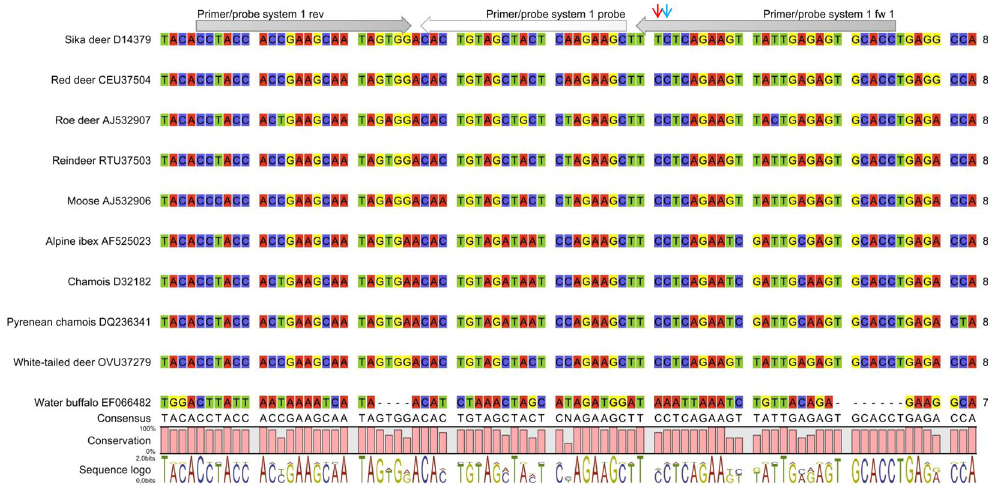
Figure 1. Sequence alignment of the kappa-casein precursor gene. Arrows indicate the position of the forward primer (1 fw 1), reverse primer (1 rev) and the probe (1 probe) of primer/probe system 1a. All forward primers of primer/probe system 1 contained the sika deer-specific base (indicated by the vertical red arrow). Forward primers 1 fw 2–4 differed from each other in the mismatch base (position indicated by the vertical blue arrow). Sequence alignment was carried out using the CLC Genomics Workbench 8.0